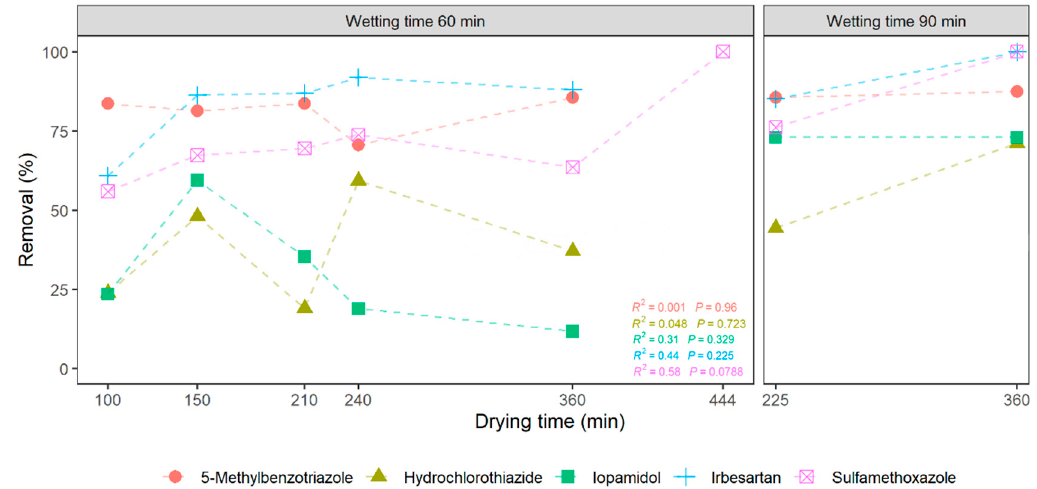
Figure 6. Removal e ffi ciency (%) of 5-methylbenzotriazole, hydrochlorothiazide, iopamidol, irbesartan Figure 6. Removal efficiency (%) of 5-methylbenzotriazole, hydrochlorothiazide, iopamidol, and sulfamethoxazole under di ff erent HLCs. Not all substances were measured for all scenarios. irbesartan and sulfamethoxazole under different HLCs. Not all substances were measured for all Significance of trends is indicated by coe ffi cient of determination (R 2 ) and probability in statistical scenarios. Significance of trends is indicated by coefficient of determination (R 2 ) and probability in significance (P). Values below DL were regarded with DL / 2. Water 2020 , 12 , x FOR PEER REVIEW statistical significance (P). Values below DL were regarded with DL/2.